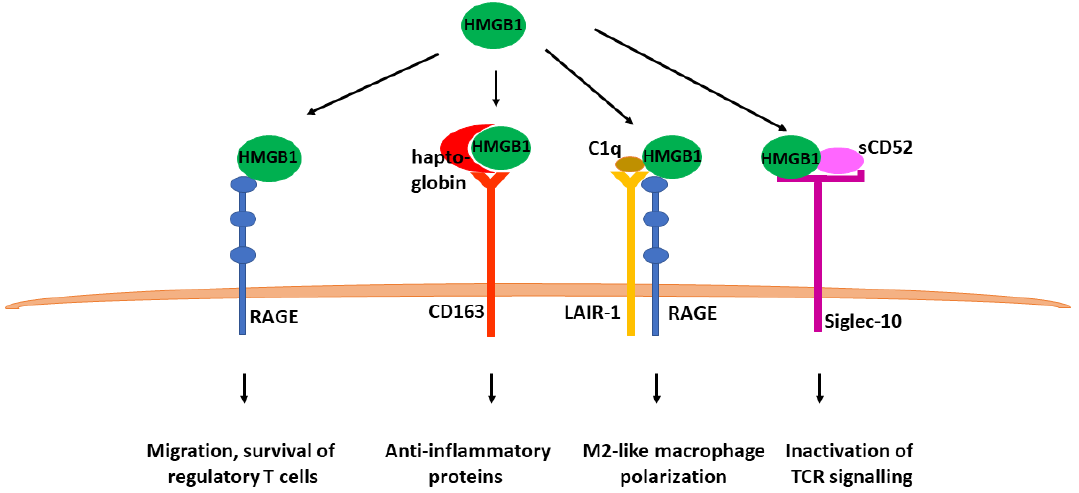
Figure 2. Anti-inflammatory activities of HMGB1. HMGB1 mediates several anti-inflammatory activities through binding to several receptors alone or in association with soluble mediators.